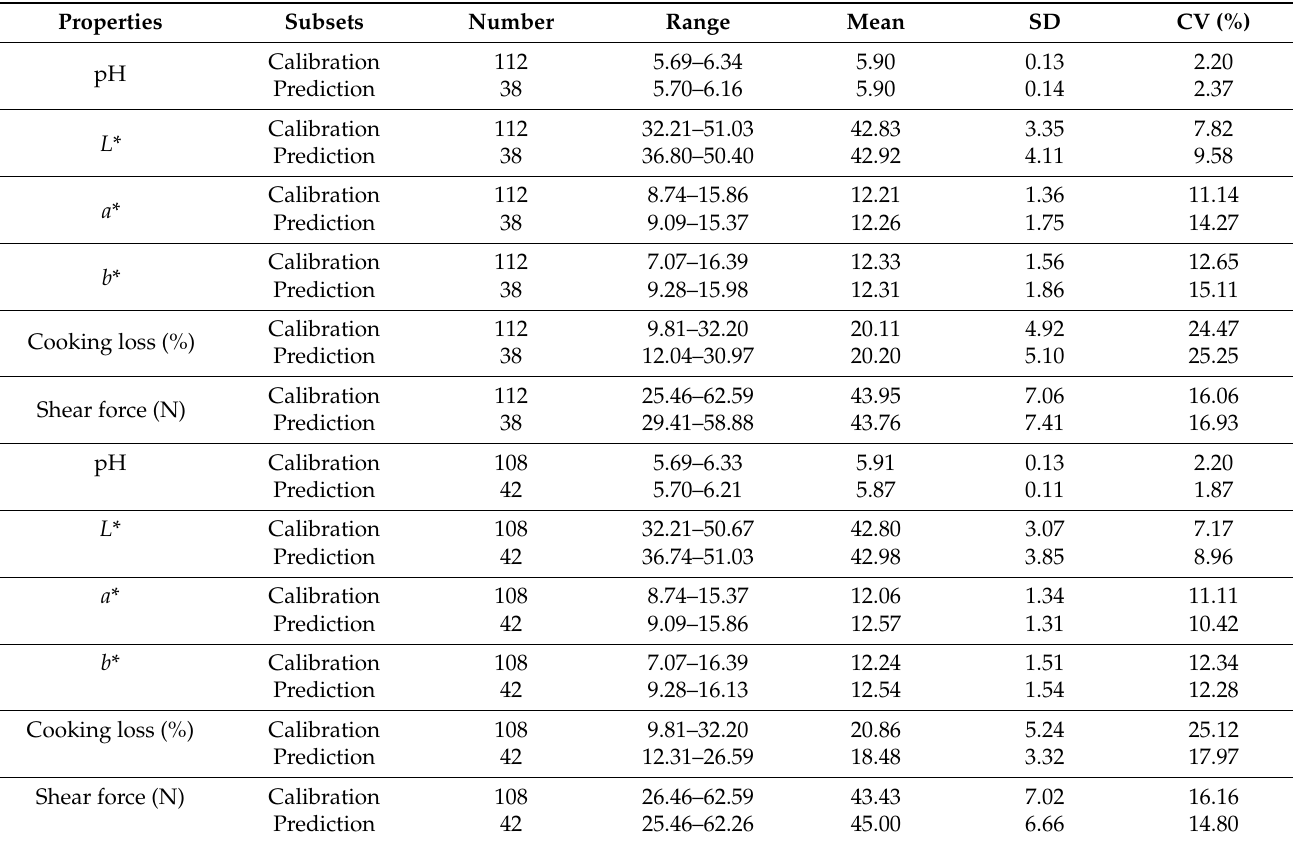
Table 3. Reference measurement of quality attributes in the calibration and prediction sets based on two sample set